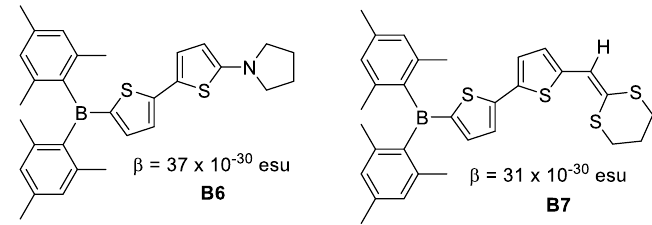
Figure 11. Hyperpolarizabilities for compounds with dimesitylboron as acceptor group, bithiophene